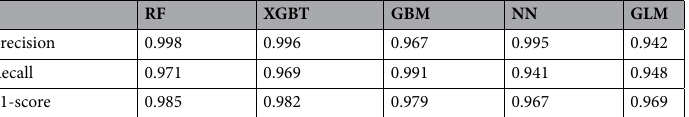
Table 8. Precision, recall and F1-score of each classification model (%). XGBT extreme gradient boosting tree model, GBM gradient boosting model, NN neural network model, GLM generalized linear model.